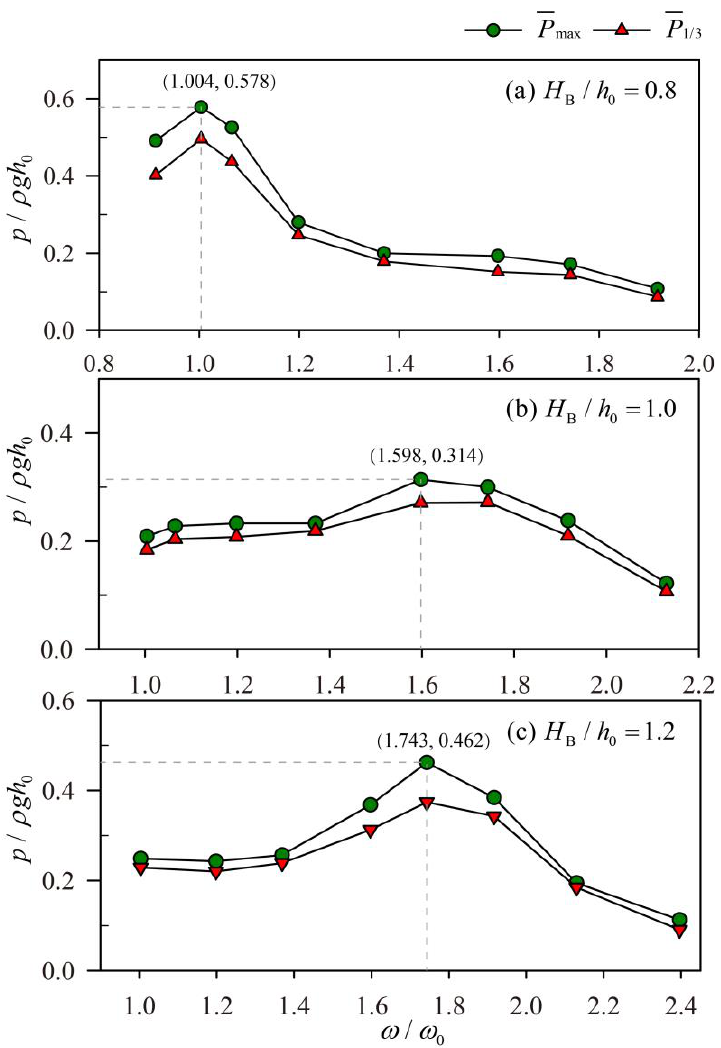
Figure 10. Variation trends of P max and P 1/3 for the three types of bottom-mounted baffles under different excitation frequencies. ( a ) H B / h 0 = 0.8; ( b ) H B / h 0 = 1.0; ( c ) H B / h 0 = 1.2.